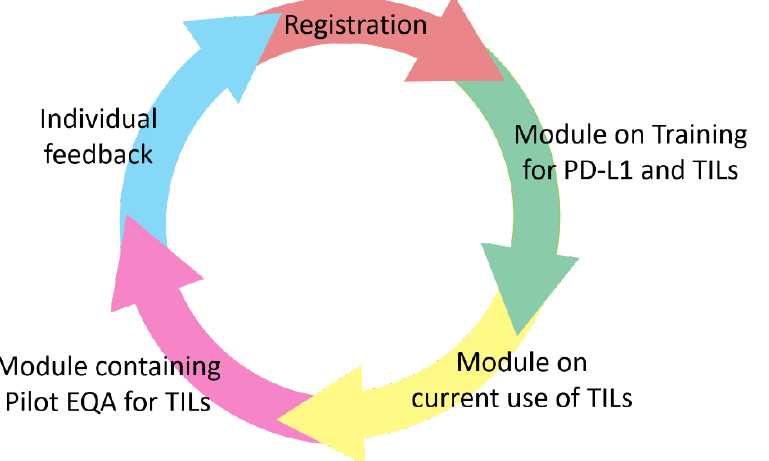
Figure 1. After registration, through www.tilsinbreastcancer.org (accessed on 15 July 2021), a training module will be available for PD-L1 and TILs. Next, a pilot EQA module will be available to assess the current practices and competences of pathologists to score TILs. Finally, individual feedback will be offered to each participant separately.